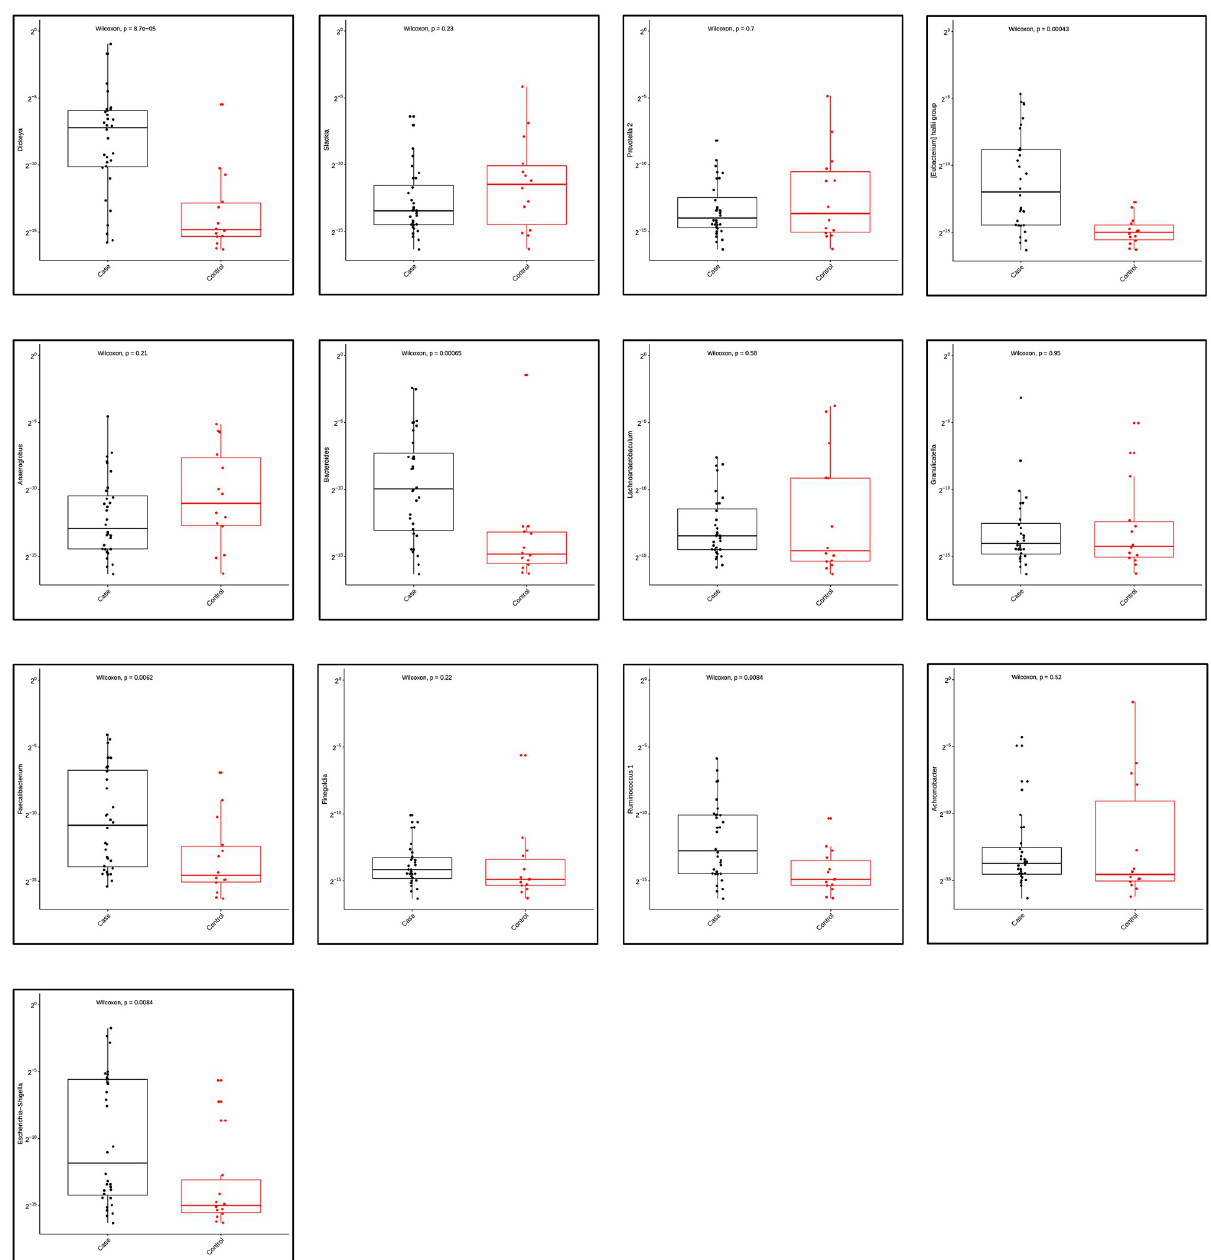
Fig 4. Mann Whitney-U test showing differential abundance of bacterial genera in bile from patients with malignant (case) and benign (control) pancreaticobiliary diseases.